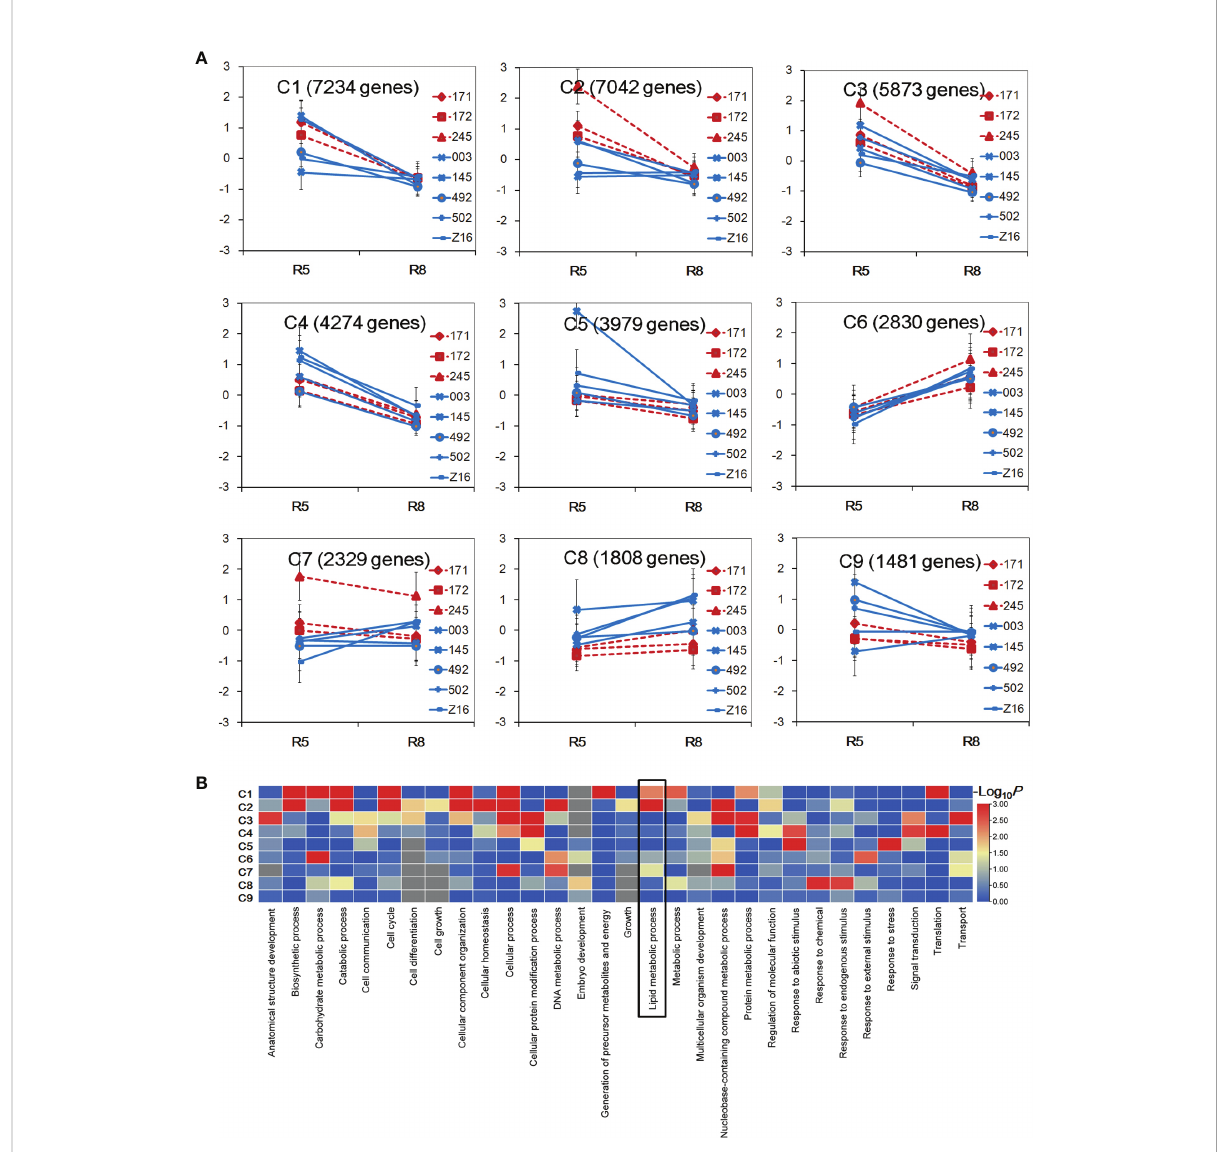
FIGURE 2 Gene expression pattern between wild and cultivated peanuts. (A) Identi fi cation of gene clusters in 16 samples. Nine gene clusters (C1 – C9) were identi fi ed using K-means clustering. The x-axis represented the stage of developing seed. The y-axis represented log2 FPKM derived from RNA sequencing (RNA-seq) data for each sample FPKM fragments per kilobase of transcript per million mapped reads. (B) Heatmap of enrichment of biological process category among nine clusters. The color was indicated – log10 ( P -value). The lipid metabolism process was boxed in the